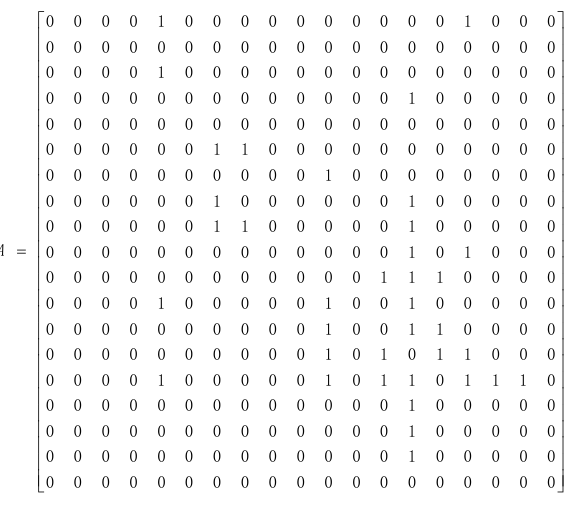
Figure 5. Adjacency matrix.